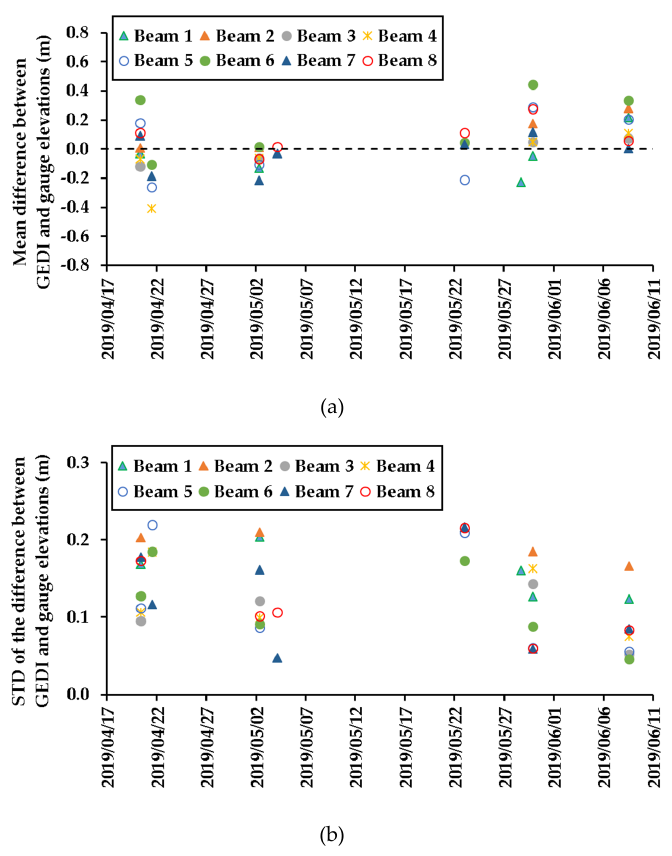
Figure 5. Mean ( a ) and standard deviation ( b ) of the difference between GEDI elevations and hydrological elevations for each date and each beam using data from all lakes.